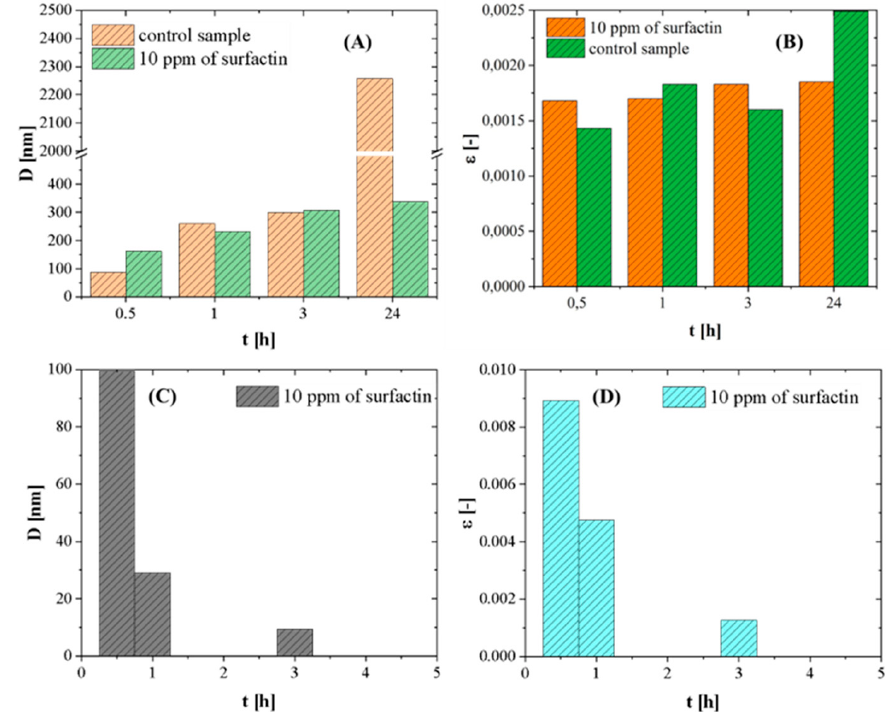
Figure 7. Changes in crystallite size ( D ) and microstrains ( ε ) of CaCO 3 crystals obtained with and without surfactin. Calcite ( A , B ); vaterite ( C , D ).